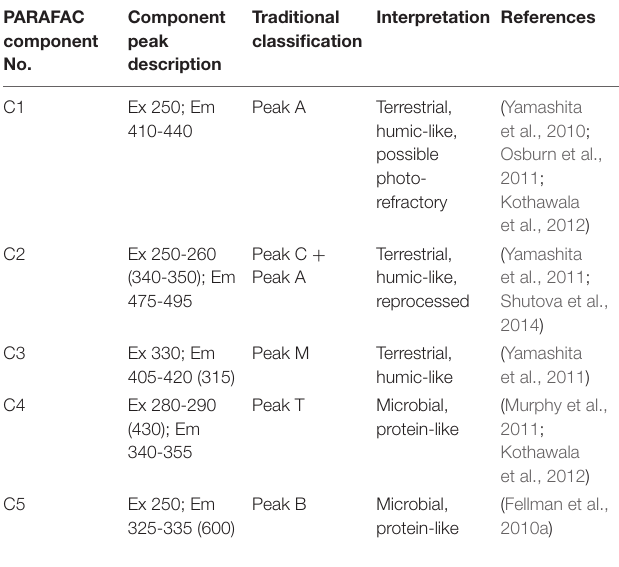
TABLE 2 | PARAFAC component summary. EEMs data were deconstructed into 5 discrete components. PARAFAC Component component No.